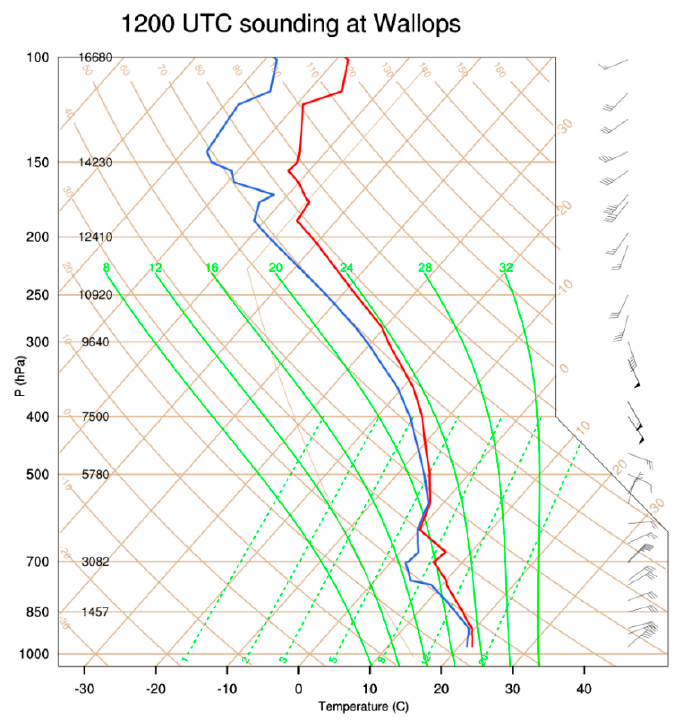
Figure 2. The 12 UTC sounding from Wallops on 16 September 2019.